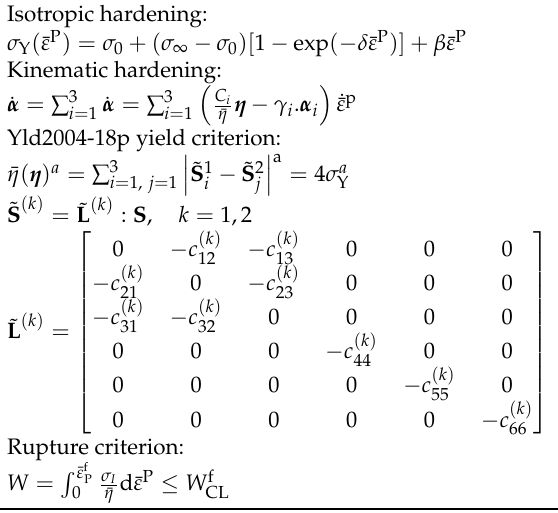
Table 1. Constitutive equations that describe the mechanical behavior of the material. Data from [4]. Isotropic hardening: